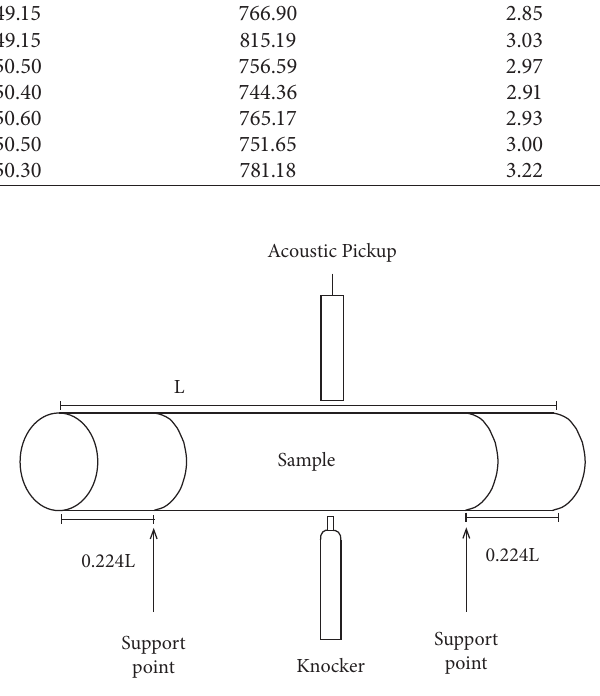
Figure 2: Detail of the positioning of the test sample. Table 3: Technical characteristics of the acoustic microphone